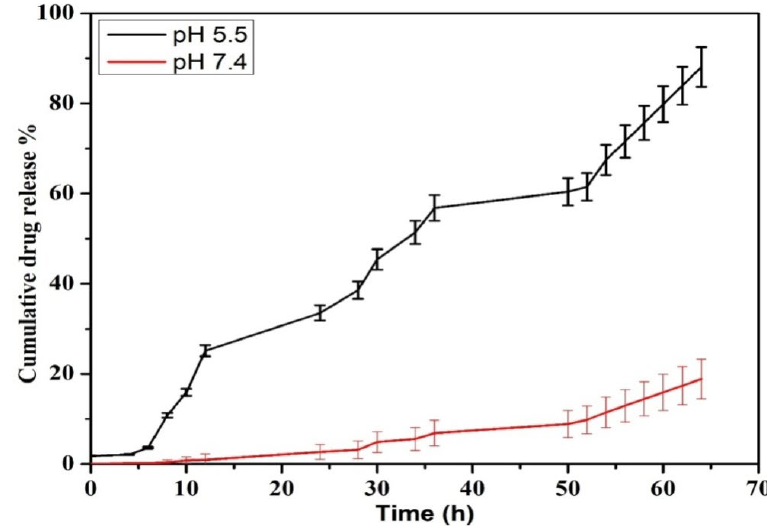
Figure 7. Drug release kinetics for PTX released from PTX-chit-SeNPs.